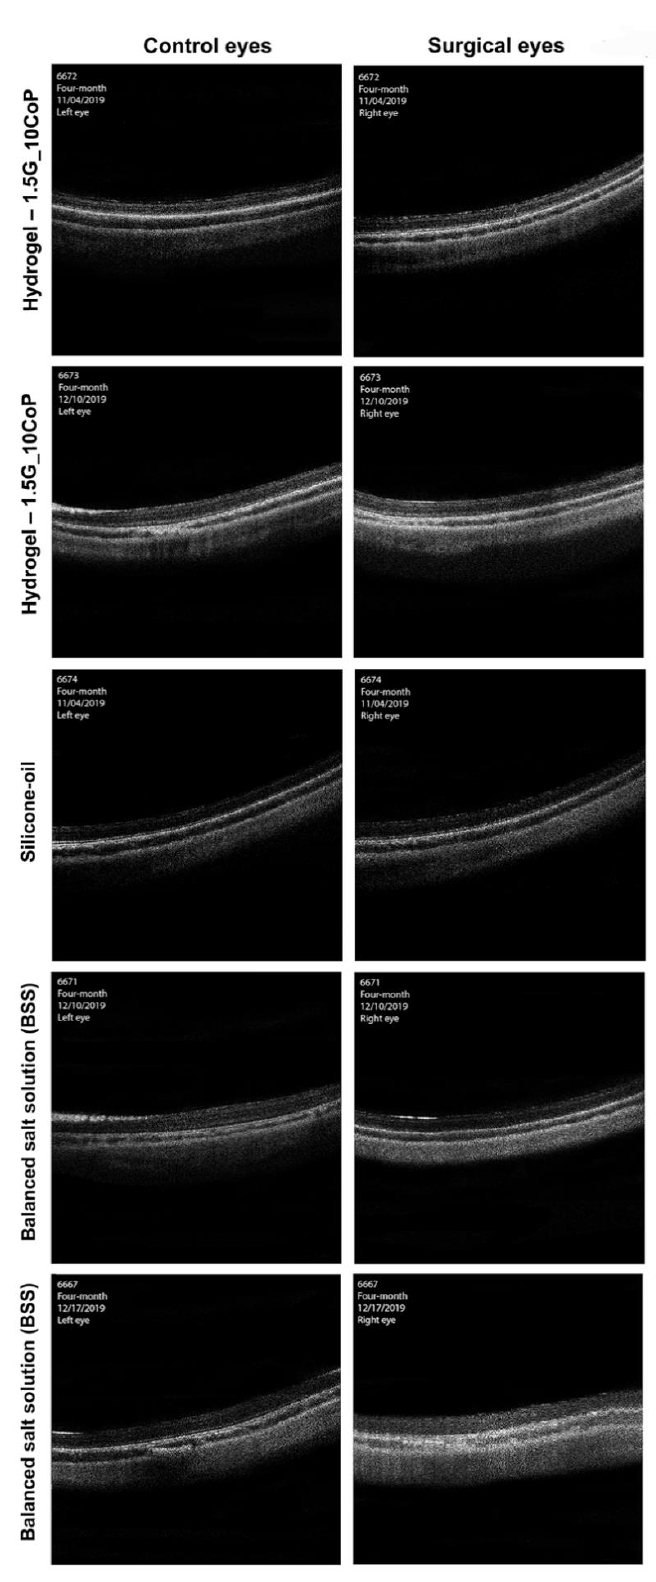
Figure 6. The optical coherence tomography (OCT) images were taken at four-month post-operative examinations. The OCT images on the left represent the control eyes, whereas the images on the right represent the surgical eyes.